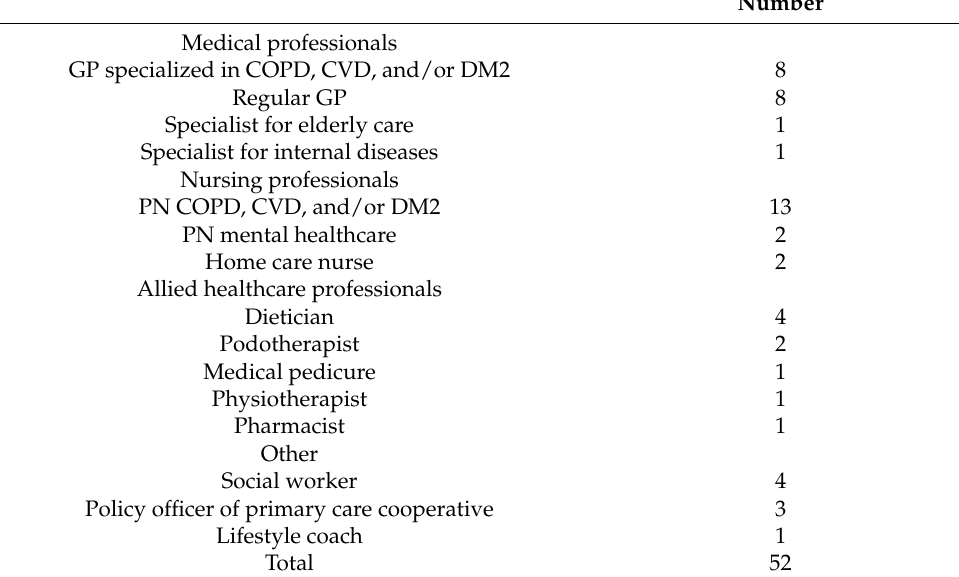
Table 4. Disciplines of the participants in the online qualitative survey